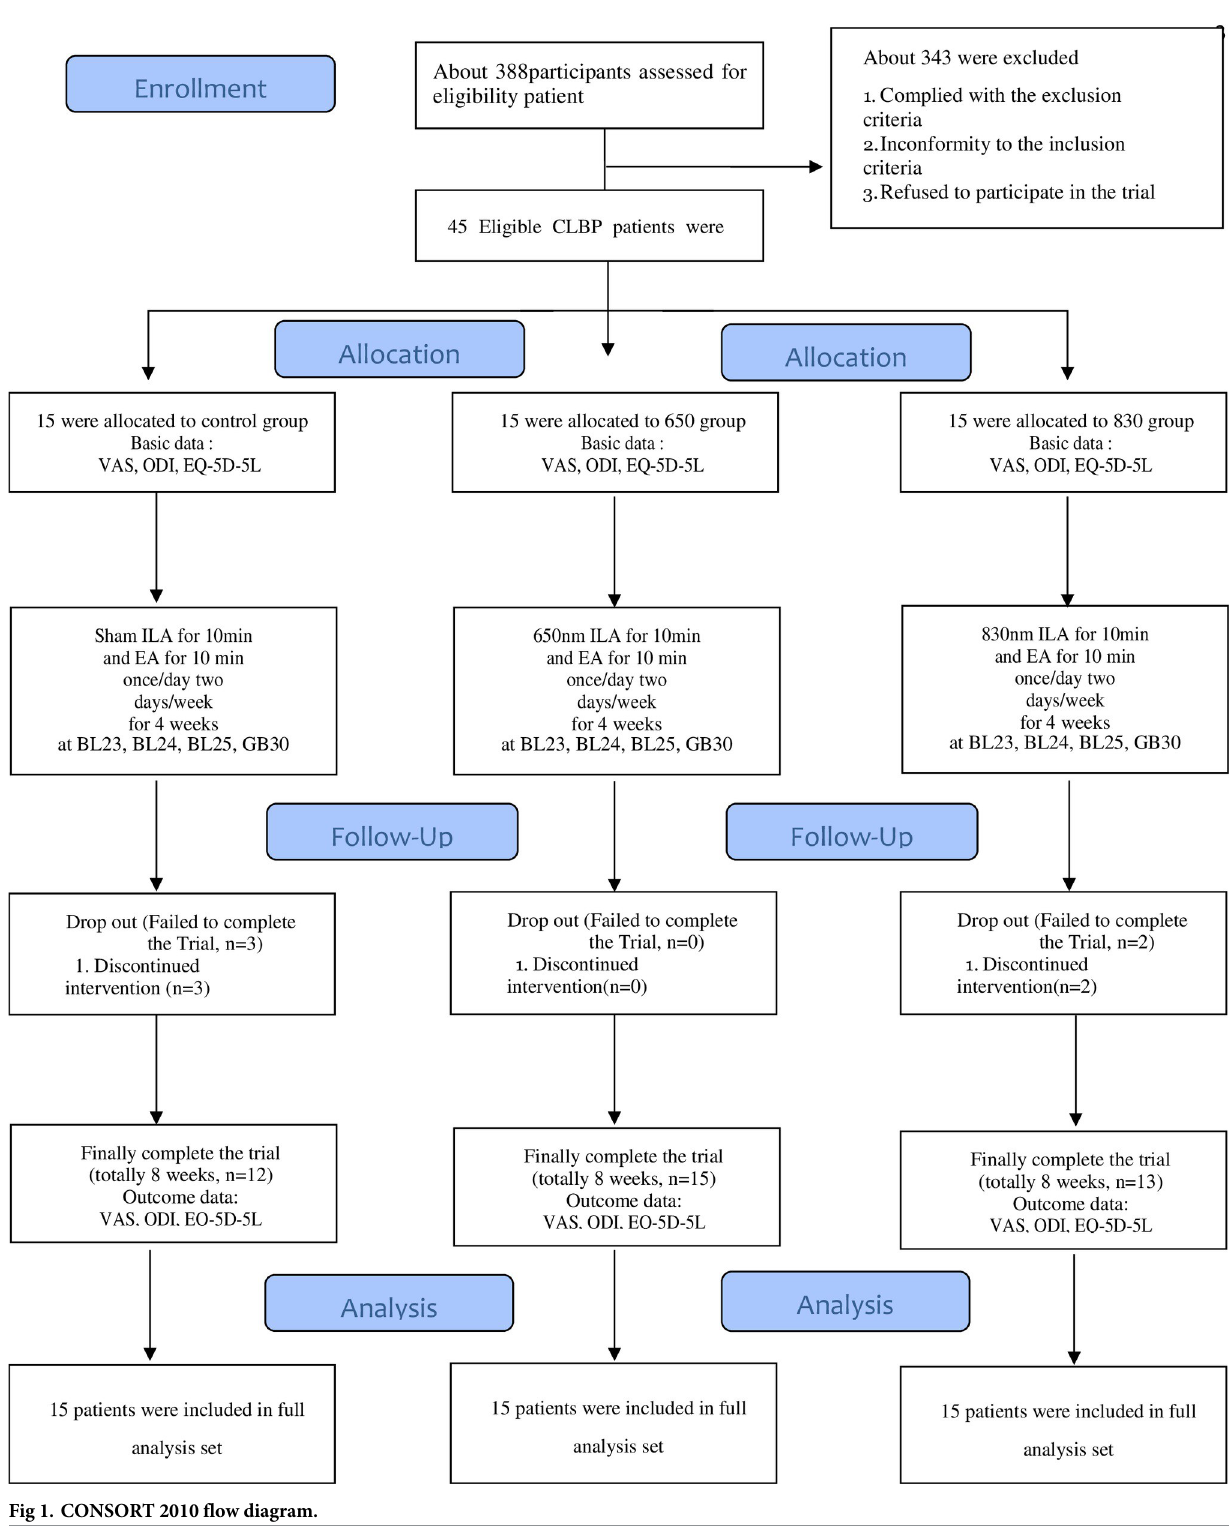
Fig 1. CONSORT 2010 flow diagram.